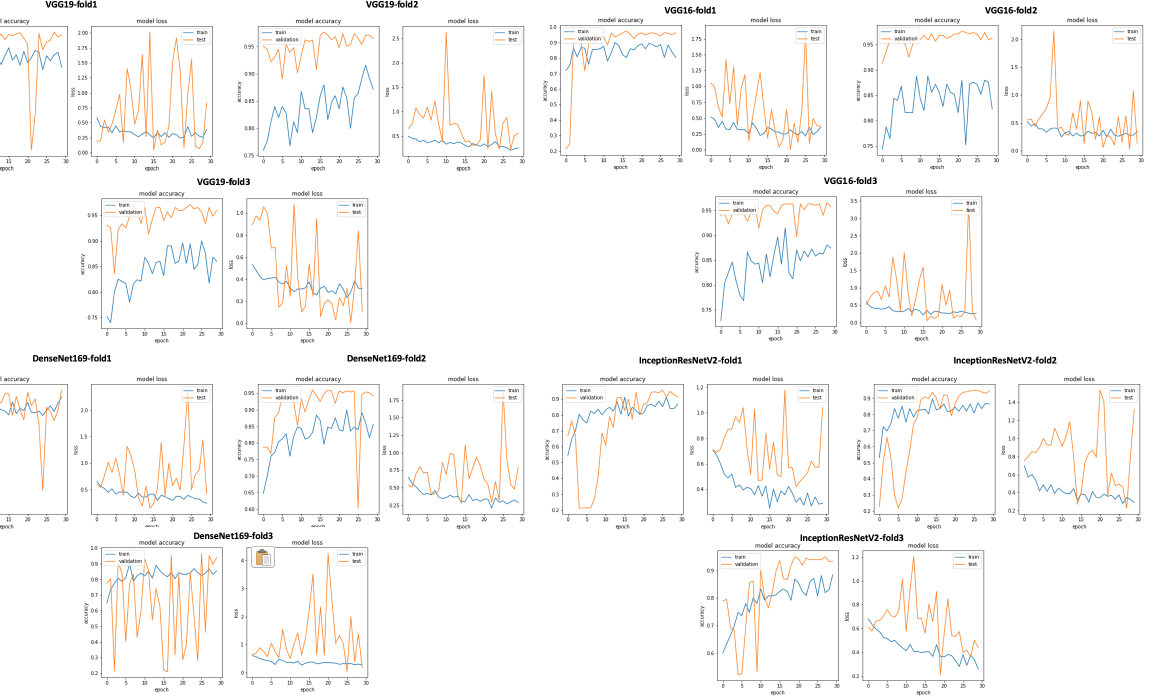
Figure 23. VGG19, VGG16, DenseNet169, and InceptionResNetV2 training and validation curves using data selection based on SNR ≥ 0.